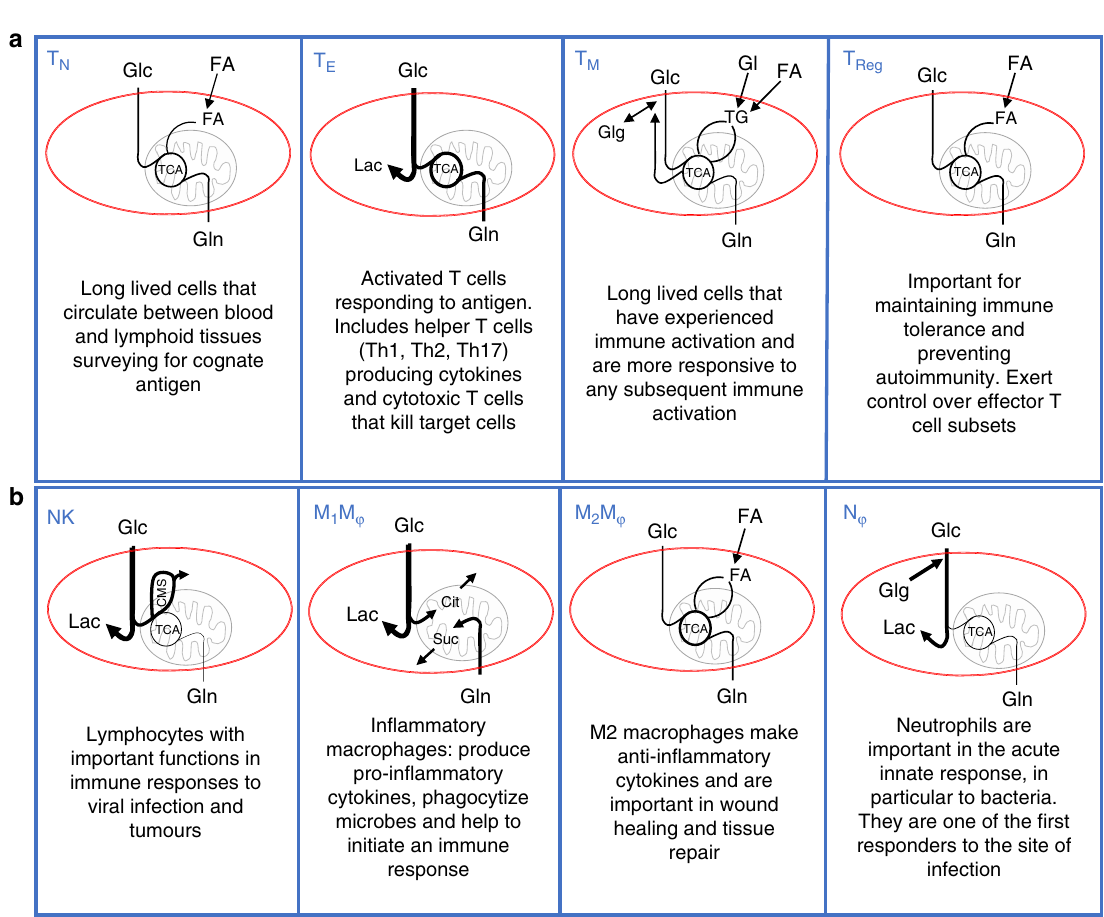
Fig. 2 Illustrating the different metabolic con fi gurations of immune cells. a T cells: Naive T cells (T N ) have low metabolic rates fueled by glucose and glutamine. Effector T cell (T E ) subsets tend to have elevated levels of both aerobic glycolysis (for metabolising glucose to lactate (Lac)) and OXPHOS (as fueled by glucose (Glc) and glutamine (Gln)). Memory T cells (T M ) maintain intracellular fuel stores in the form of glycogen (Glg) and triacylglycerides (TG) fueled by glucose and fatty acid (FA) uptake, and primarily use OXPHOS rather than glycolysis. T M have metabolic plasticity as they can engage multiple opposing metabolic pathways including gluconeogenesis/glycolysis, glycogenesis/glycogenolysis and FA synthesis/FA oxidation. TG stores are generated using imported glycerol (Gl). This metabolic con fi guration supports two key features of T M cells; long term survival by providing dependable fuel sources within the cell (TG and Glg) and rapid metabolic responses to re-stimulation because the metabolic machinery is already present and in use. Regulatory T cells (T Reg ) import FA for use in biosynthesis and to generate energy through FA oxidation. b Other immune cells: Natural killer (NK) cells primarily use glucose as a fuel, which supports aerobic glycolysis and drives OXPHOS through the citrate-malate shuttle (CMS) but not the TCA cycle.